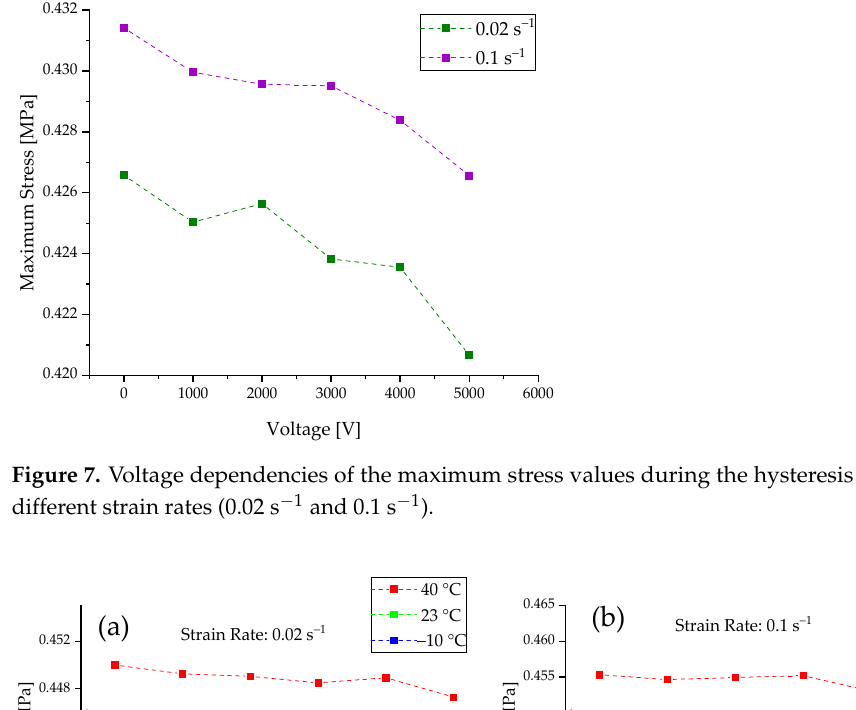
Figure 6. Stress–strain hysteresis at a strain rate of 0.02 s − 1 for the ( a ) DEA (no activation) and ( b ) dielectric layer at different temperatures.